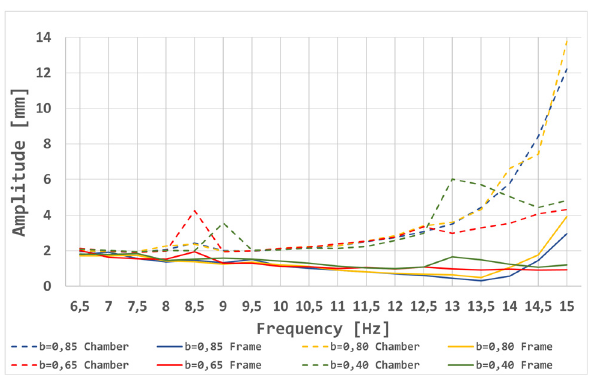
Figure 11: Quasi steady start up. Accelerations of the chamber and drive frame. Overall fi